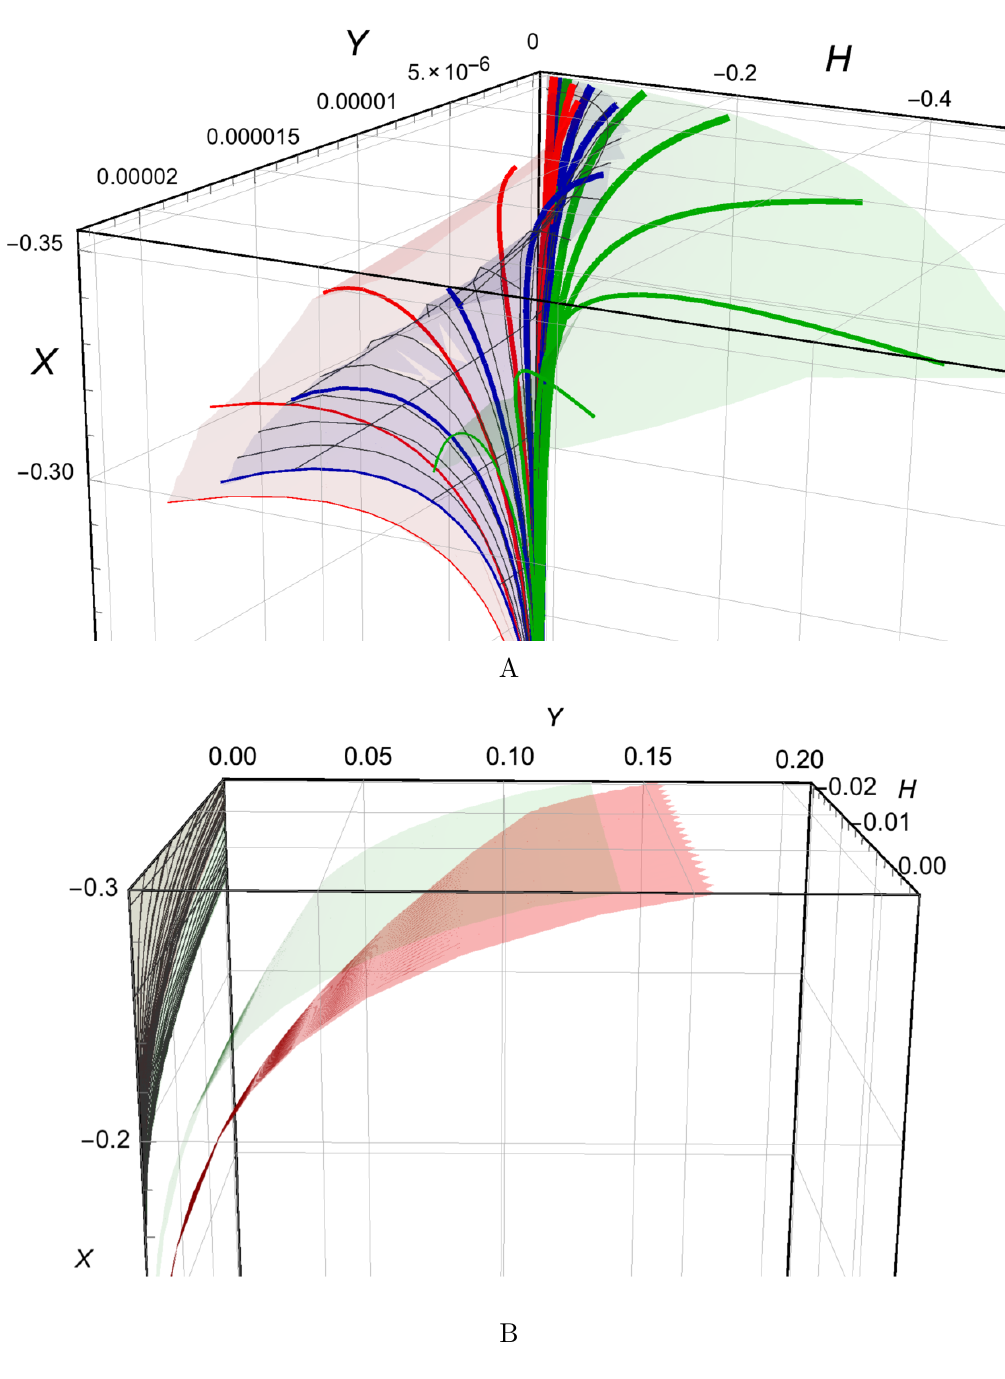
Figure 17 . RG (cid:13)ows in the ( X; Y; H )-space in anisotropic case (cid:23) = 4 : 5 for z h = 2 (light red), z h = 1 : 5 (light blue) and z h = 1 (lightgreen) (A); RG (cid:13)ows in the ( X; Y; H )-space in anisotropic, (cid:23) = 4 : 5, (meshed lines) and isotropic cases (not meshed lines) for z h = 1 (lightgreen) and z h = 2 (lightred)